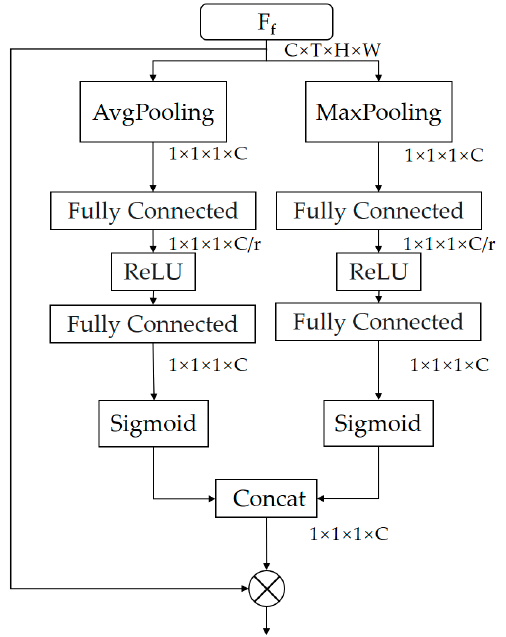
Figure 6. Spatial attention module.